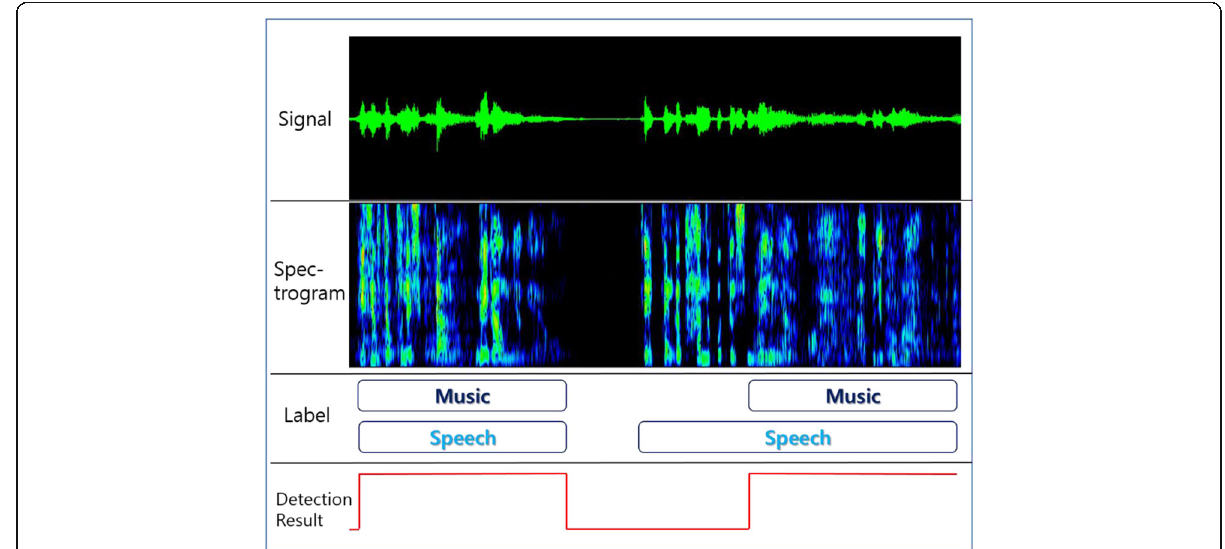
Fig. 2 An example of music